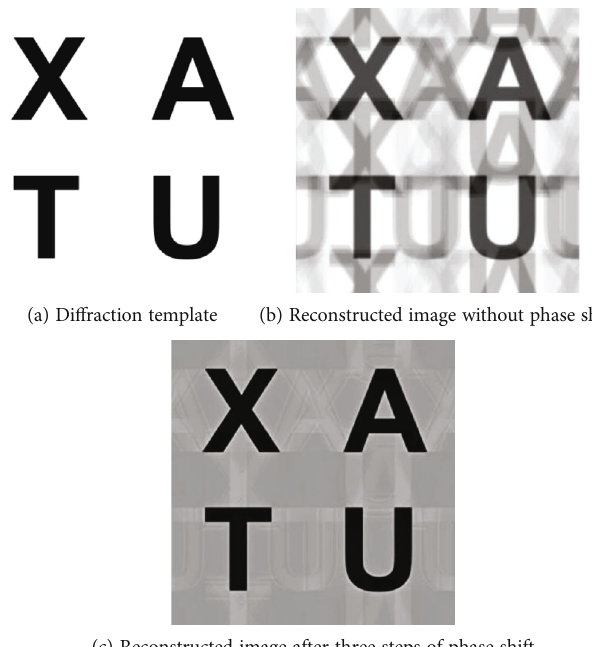
Figure 7: Comparison of reconstructed images without phase shift and after three steps of phase